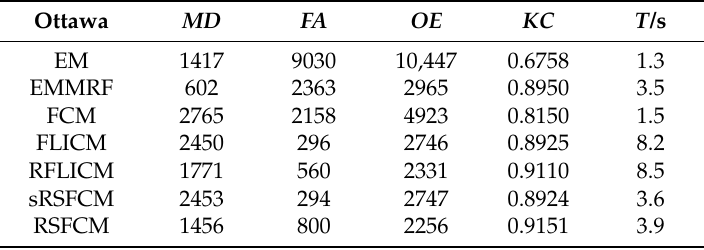
Table 3. Change detection results on Ottawa